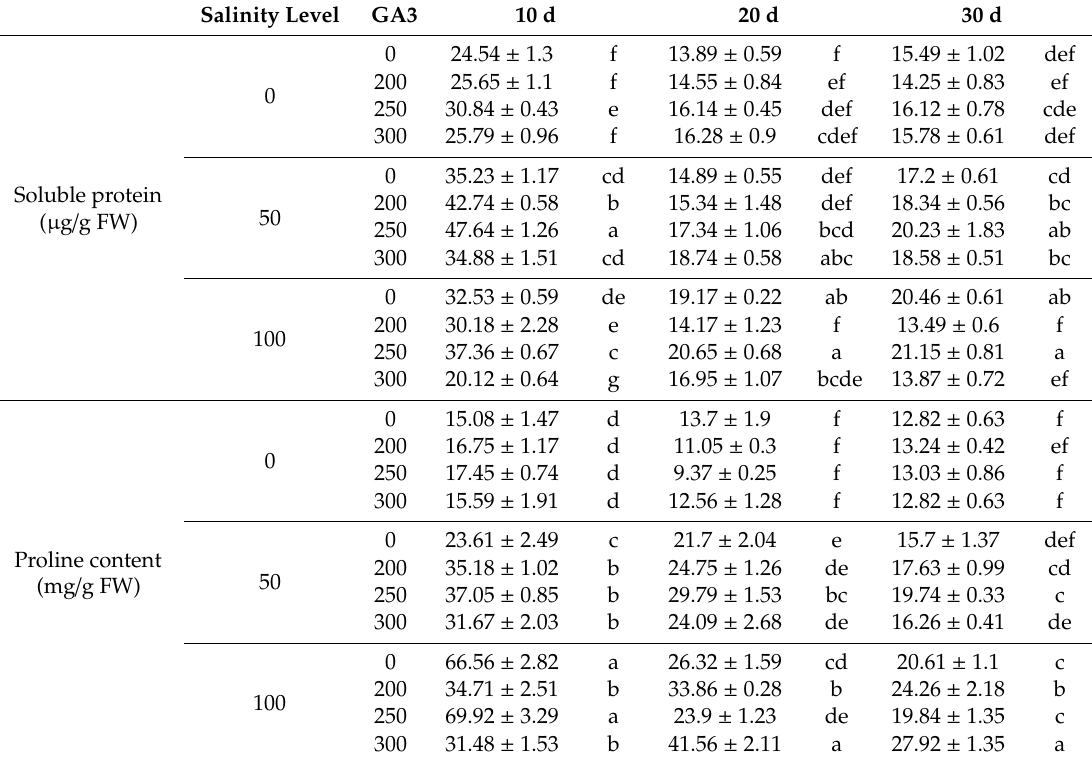
Table 5. E ff ects of di ff erent levels of exogenous GA 3 on soluble protein and proline content of caster bean seedlings grown under three levels of NaCl treatment: 0 (control), 50, and 100